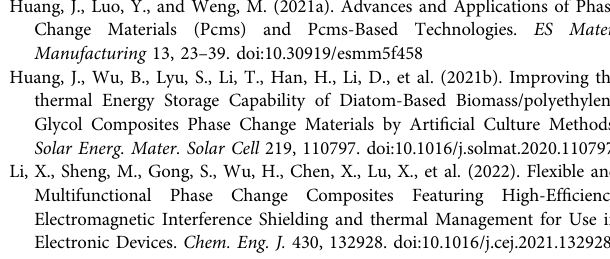
Frontiers in Chemistry |